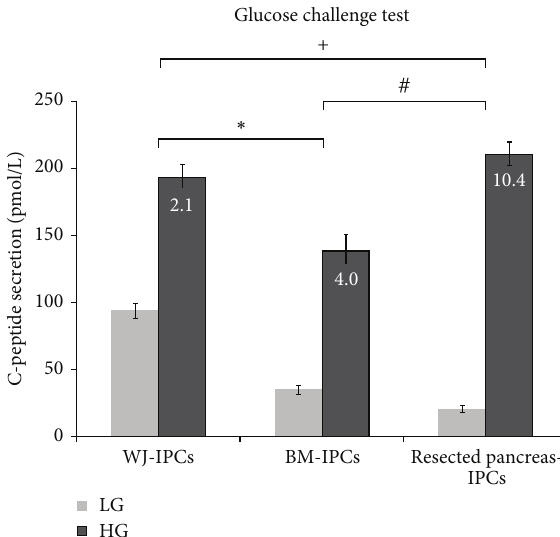
Figure 3: Secretion of C-peptide by cultured human IPCs in response to glucose stimulation. Glucose challenge test for C-peptide release in response to low glucose (LG: 5.5 mM) and high glucose (HG: 25 mM) concentrations of differentiated cells. ( + : the increasing fold of resected pancreas compared to the increasing fold of Wharton’s jelly, 𝑃 < 0.05 ; # : the increasing fold of resected pancreas compared to the increasing fold of bone marrow, 𝑃 < 0.05 ; ∗ : the increasing fold of bone marrow compared to the increasing fold of Wharton’s jelly).